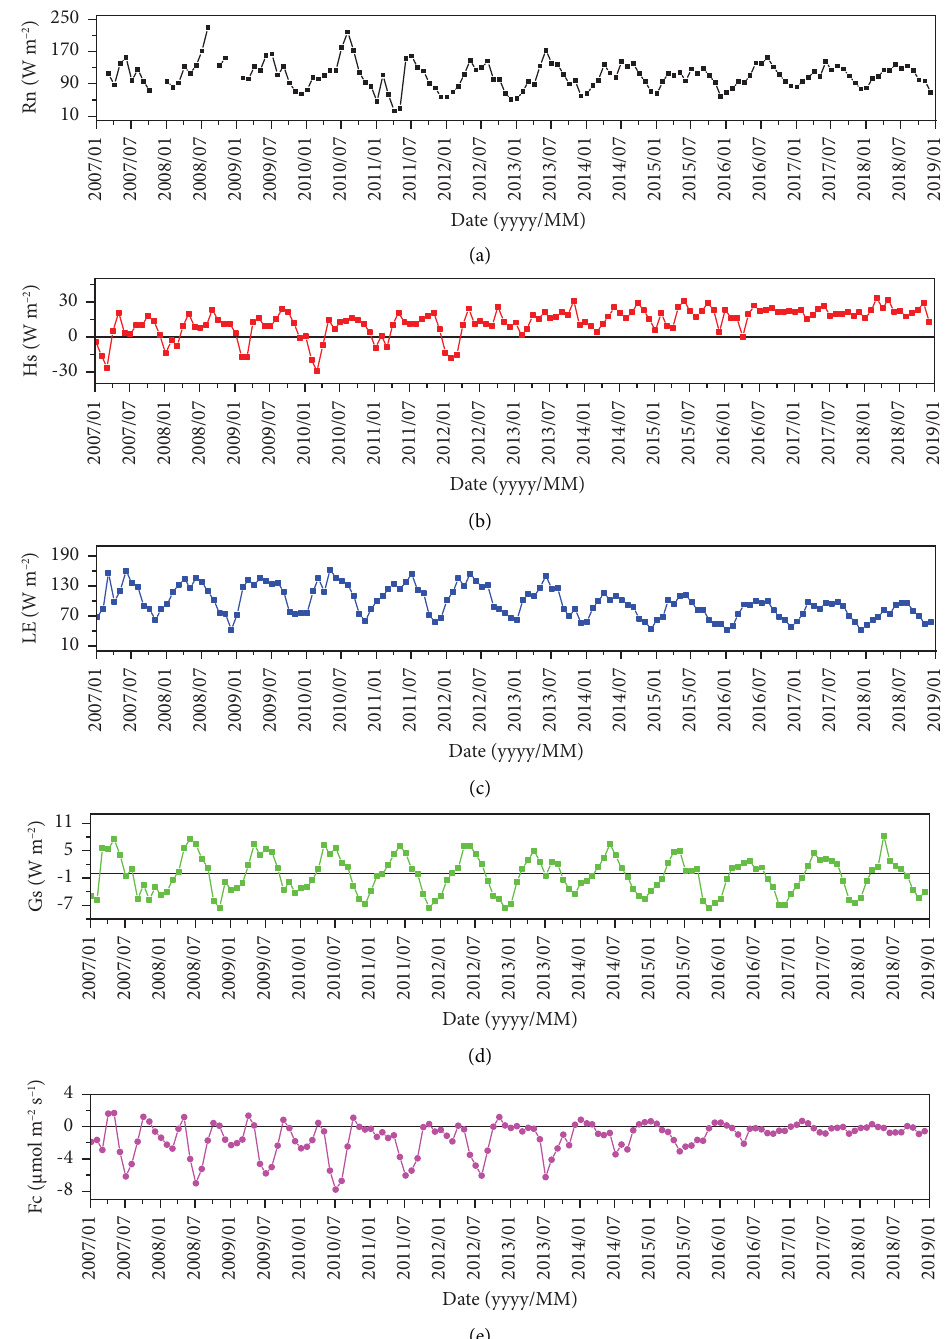
Figure 8: Seasonal and interannual variations in monthly averaged net radiation fux (Rn) (a), sensible heat fux (Hs) (b), latent heat fux (LE) (c), soil heat fux (Gs) (d), and CO 2 fux (Fc) (e) from 2007 to